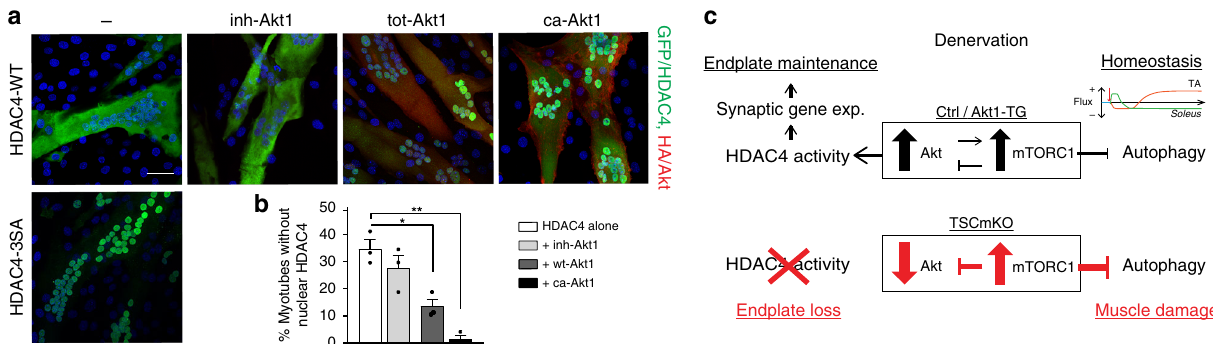
Fig. 9 PKB/Akt promotes HDAC4 nuclear import in muscle cells. a , b Fluorescent pictures of C2C12 myotubes co-electroporated with a wild-type form (WT) of HDAC4 tagged with GFP or with a nuclear mutant (HDAC4-3SA), together with an inhibited (inh), a wild-type (wt) or a constitutively active (ca) form of Akt1 tagged with HA. Scale bar, 50 µ m. The quanti fi cation in ( b ) gives the proportion of myotubes with only cytoplasmic HDAC4 localization; data are mean ± s.e.m.; total myotubes counted = 406 ( − ), 322 (inh), 356 (wt), 205 (ca); one-way ANOVA with Tukey ’ s post-hoc test, * p < 0.05, ** p < 0.01. c Scheme illustrating the role of mTORC1 and PKB/Akt in the muscle response to denervation. Source Data are provided in the Source